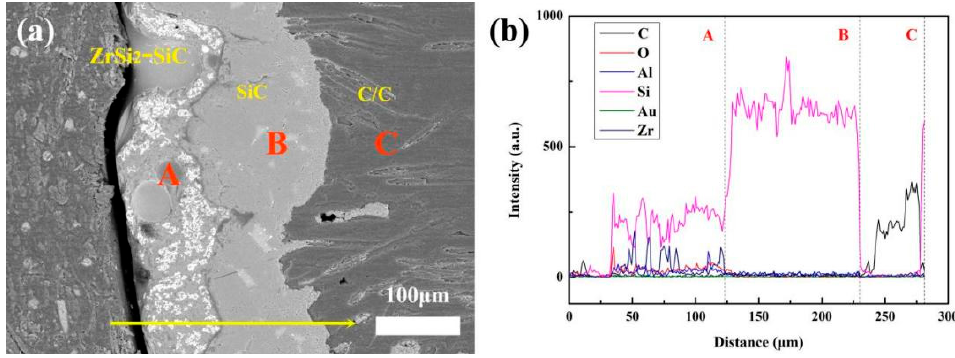
Figure 11. The cross-section image and EDS results of the sample with 30 wt.% ZrSi 2 in the ZrSi 2 -SiC outer coating after 198 h oxidation at 1500 °C. ( a ) SEM image of cross section and ( b ) EDS results.